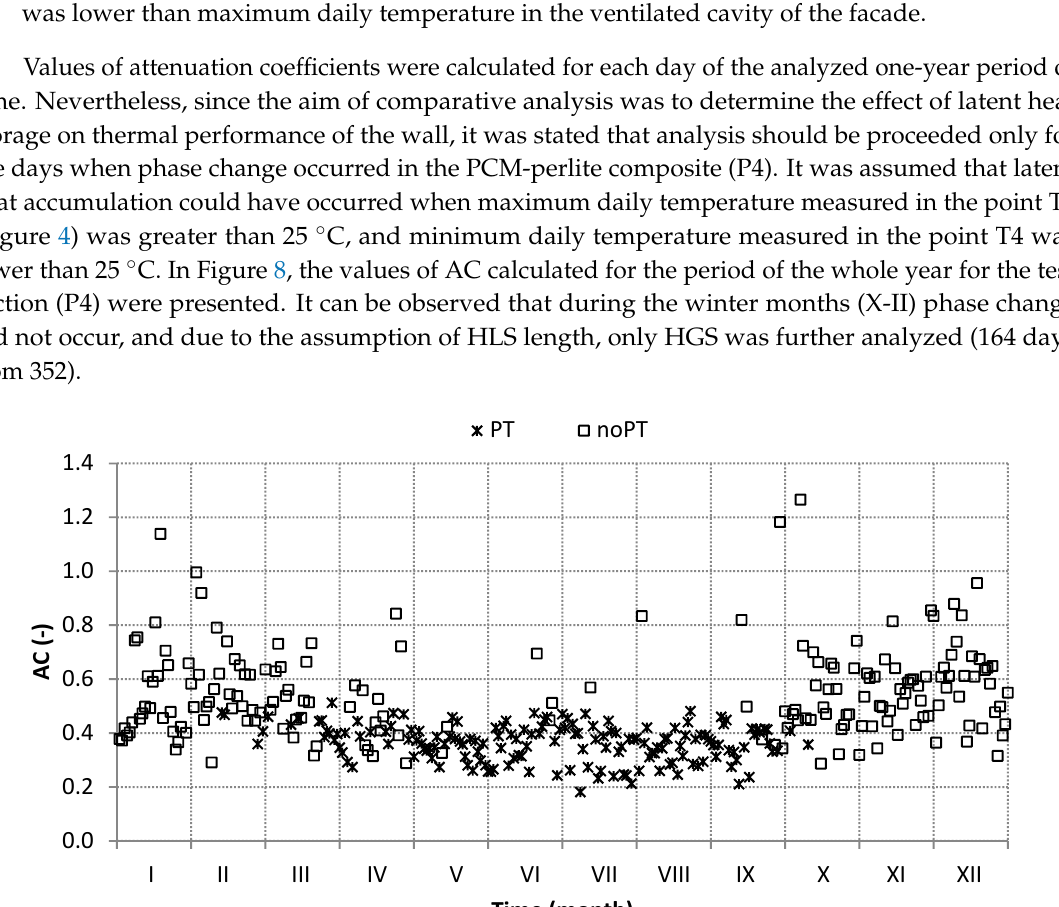
0.00.20.40.60.81.01.21.4 Figure 8. The attenuation coefficient (AC) values calculated for test section modified with PCM (PT—results for these days when phase transition occurs, noPT—results for the days without phase transitions). Figure 9. The AC values calculated for two test sections: PCM—modified with PCM (P4), REF— reference one (P6). Based on the results presented in Figure 9 it can be clearly noticed that the values of AC calculated for the reference test section (P6 = REF) are much higher than for PCM-perlite composite (P4 = PCM). The mean value obtained for P4 was almost two-fold lower than for P6 (0.36 and 0.66